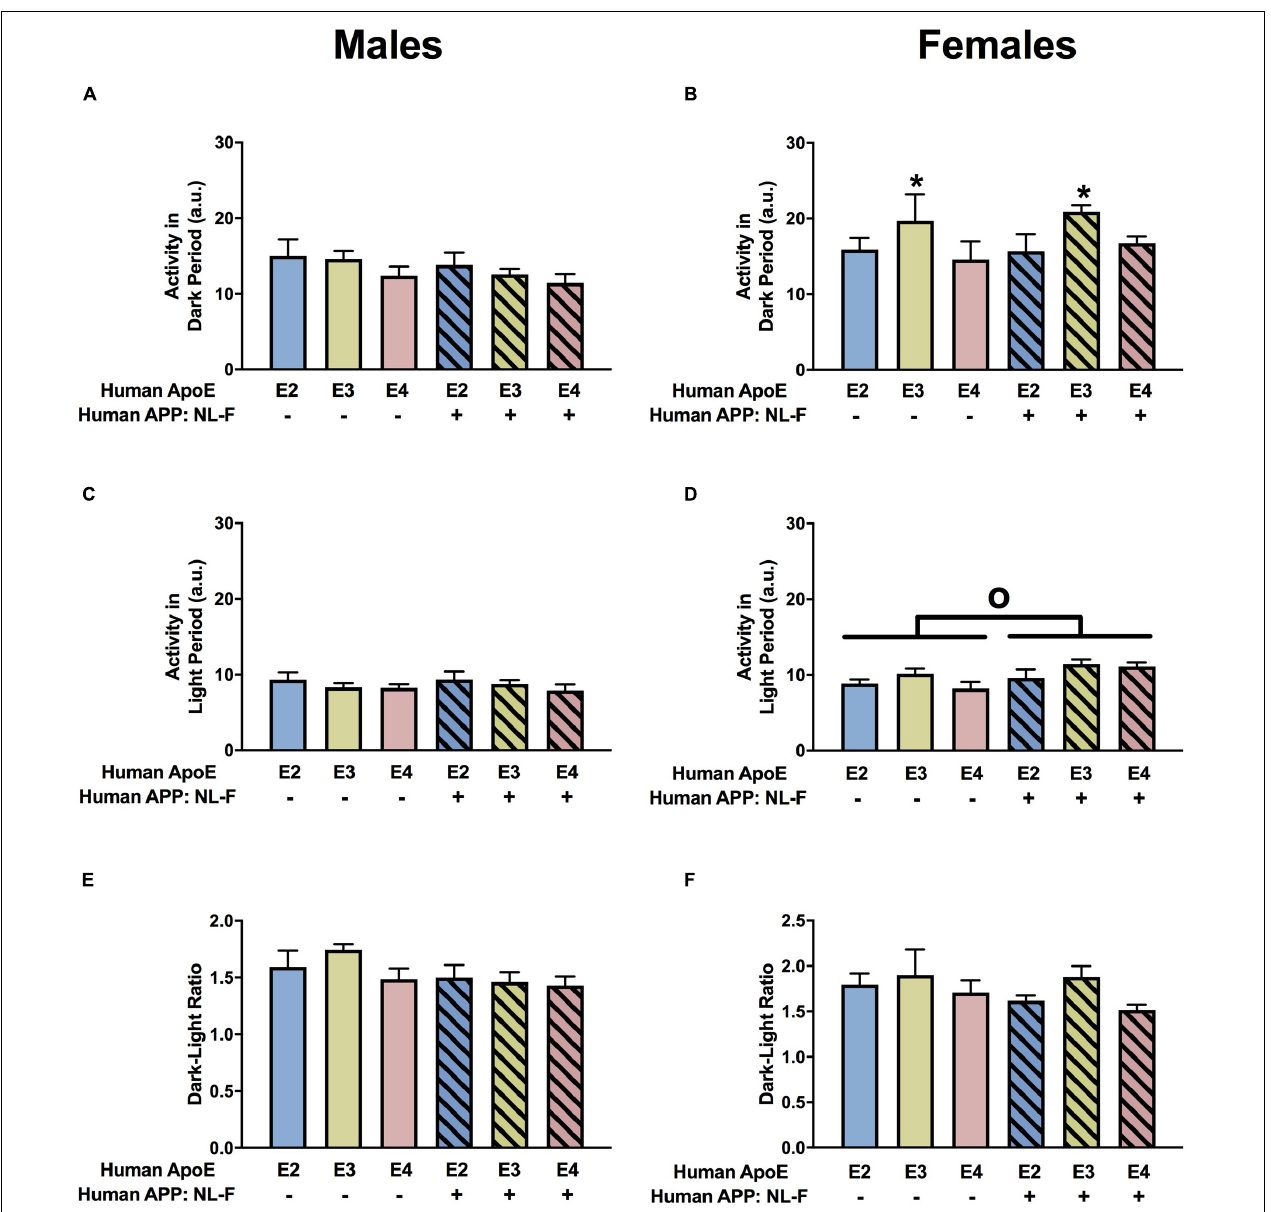
FIGURE 8 | Home cage activity in males (A,C,E) and females (B,D,F) at the 18-month time point. (A) Activity of the males during the dark period. (B) There was an effect of APOE on activity levels of females during the dark period. E3 females were more active during the dark period than E2 and E4 females. * p < 0.05. (C) Activity of the males during the light period. (D) There was an effect of APP on activity of females during the light period. NL-F mice were more active during the light period. o p < 0.05. (E) There was a trend toward an effect of APP on the dark/light ratio of males, with a trend toward a lower dark/light ratio in NL/F males. (F) Dark/light ratio of